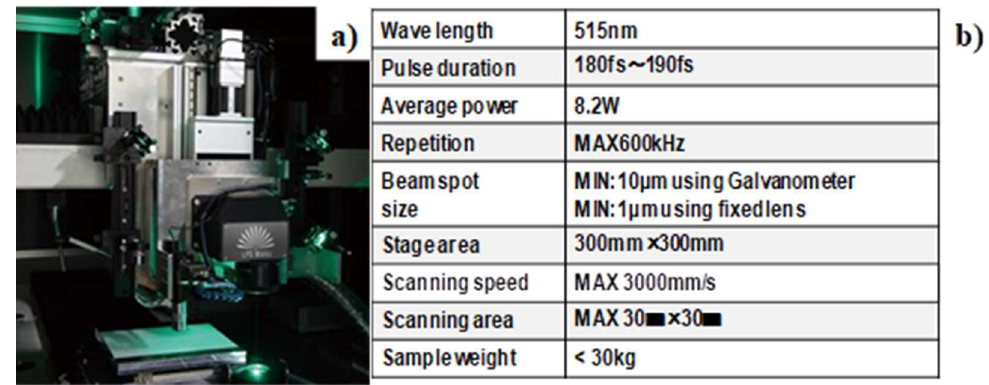
Figure 1. Femtosecond laser machining system for micro-/nano-texturing into AISI304 substrate surfaces. ( a ) Outlook of system, and ( b ) its fundamental features.